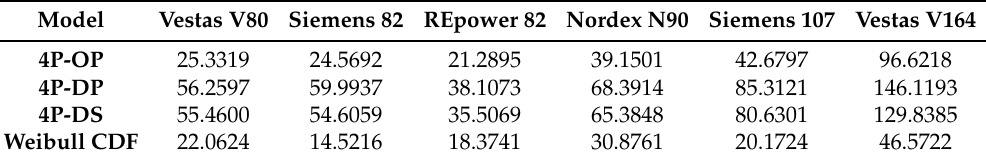
Table 3. Comparison of RMSE values for several WTs.